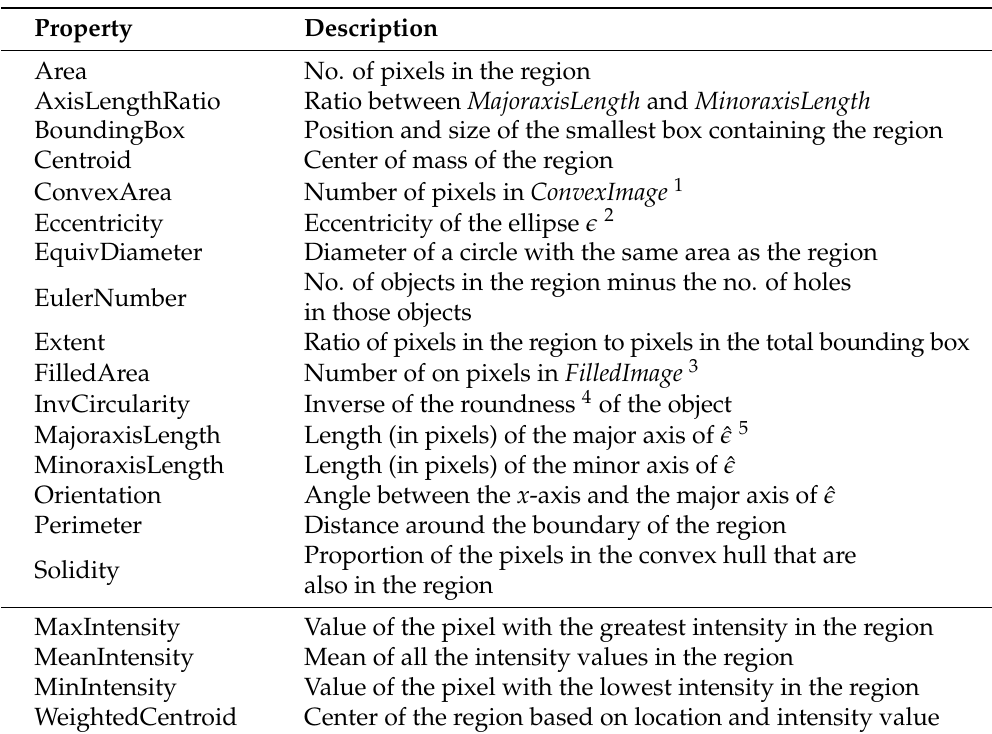
Table A1. Name and description of the handcrafted features. Top part of the table corresponds to shape measurements, while the bottom half are pixel value